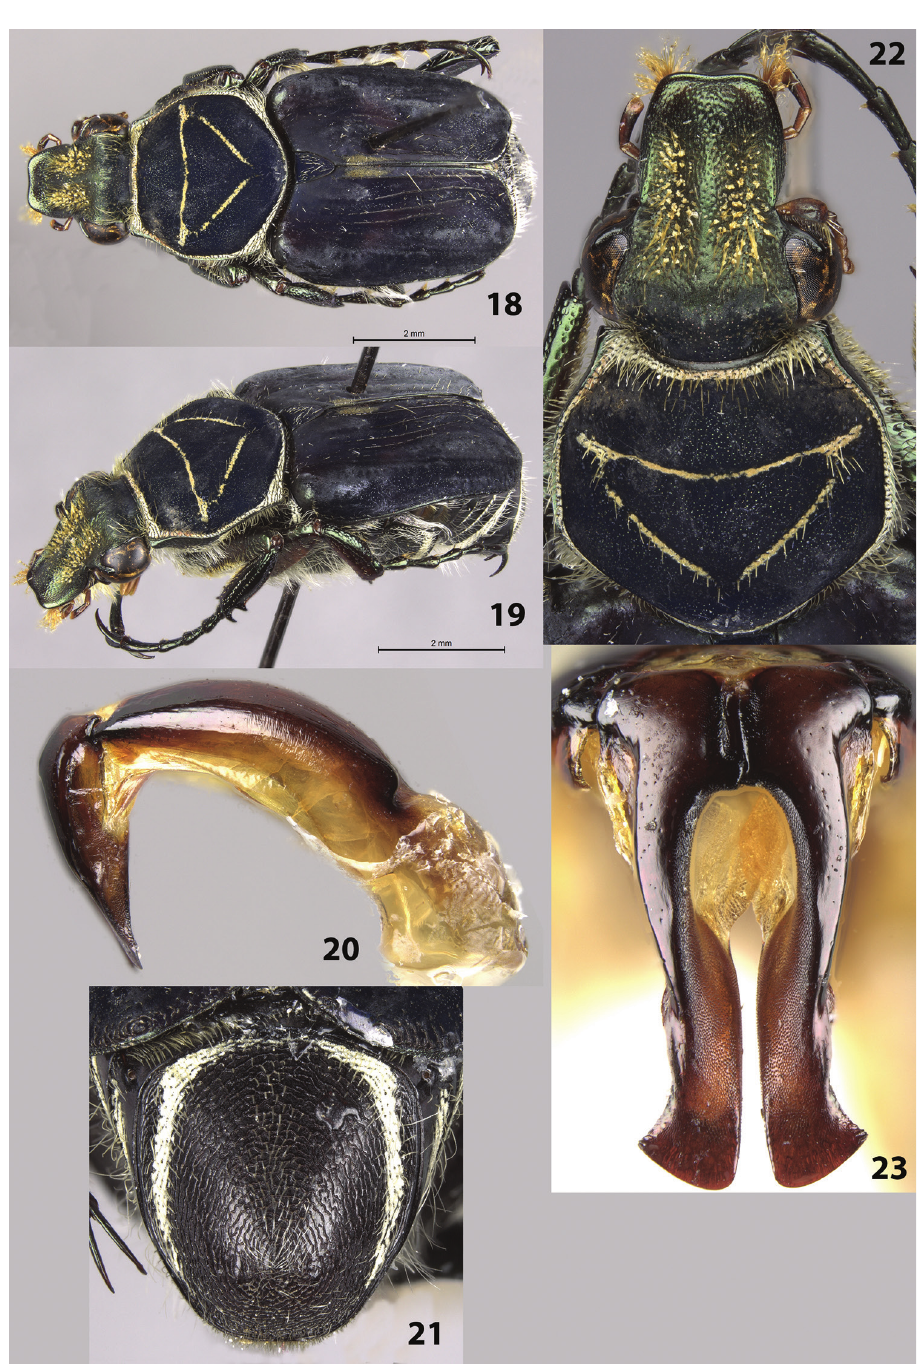
Figures 18–23. Trigonopeltastes henryi sp. n., male holotype. 18 Dorsal view of habitus 19 Oblique view of habitus 20 Lateral view of genitalia 21 Pygidium 22 Head and pronotum 23